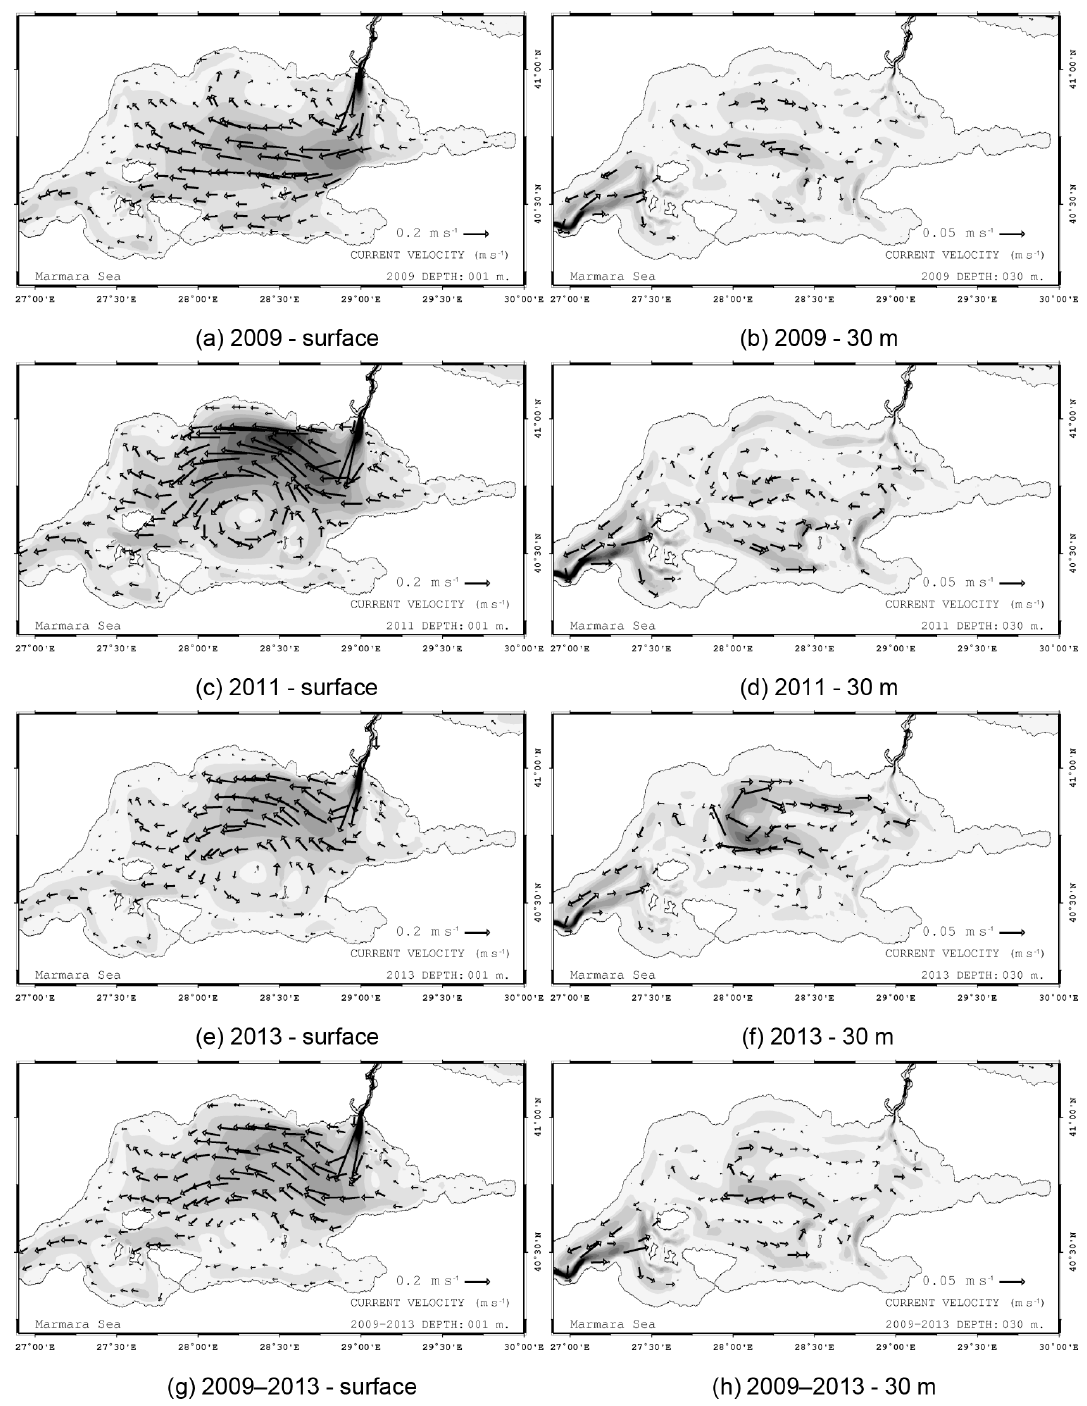
Figure 18. Annual mean of current velocity in the Sea of Marmara for (a) 2009 at the surface, (b) 2009 at 30m, (c) 2011 at the surface, (d) 2011 at 30m, (e) 2013 at the surface and (f) 2013 at 30m. The means for the 2009–2013 period are shown in panel (g) at the surface and panel (h) at